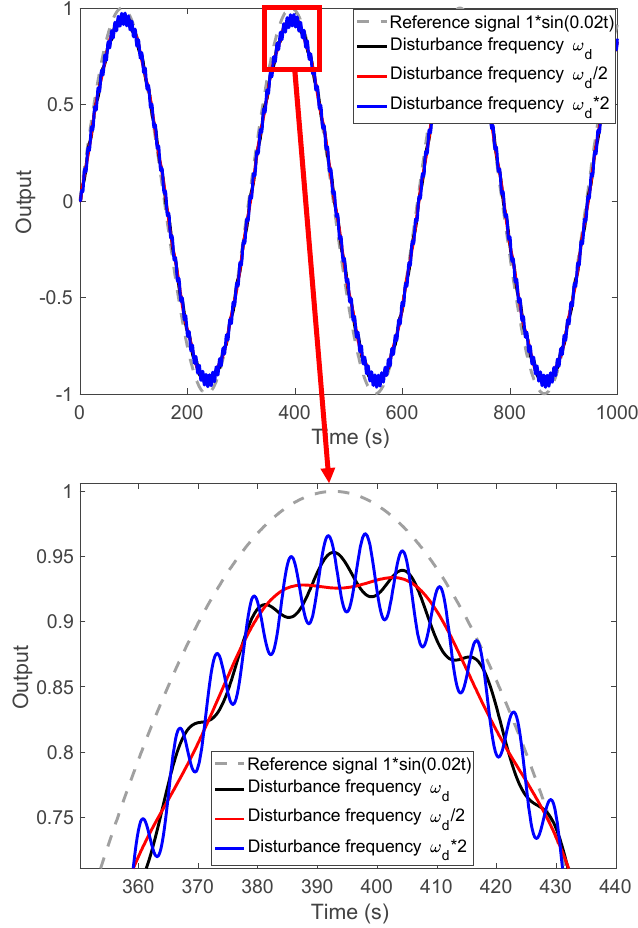
Figure 15. Robustness of a suboptimal fractional-order controller to sinusoidal disturbance frequency variations.